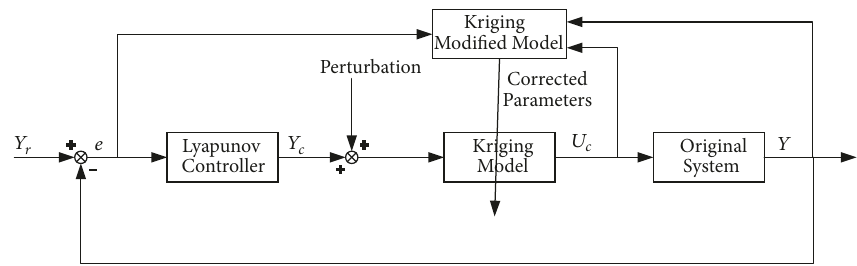
Figure 7: Adaptive inverse control approach.